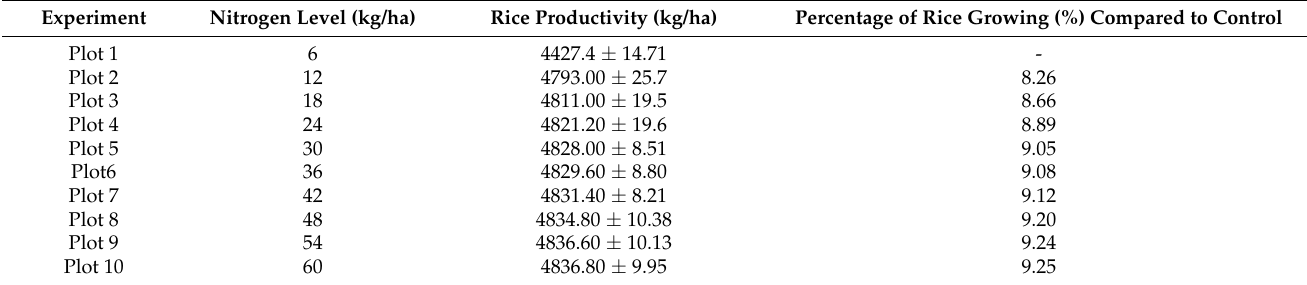
Table 4. Percentage of rice growing when the level of nitrogen fertilizer